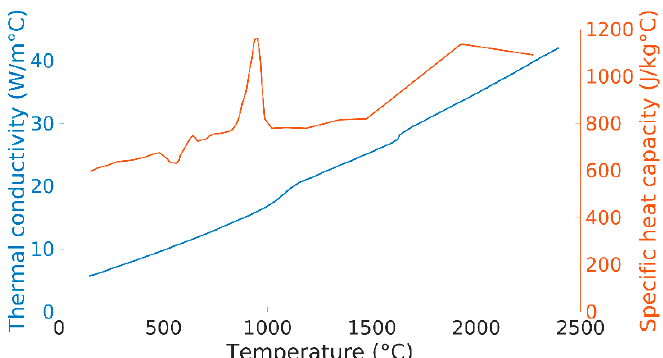
Figure 2. Material data used in the thermal model.